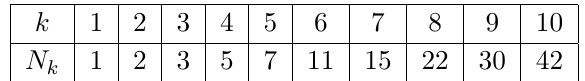
Table 1 . The number N k of possible Ricci polynomial terms at the k ’th